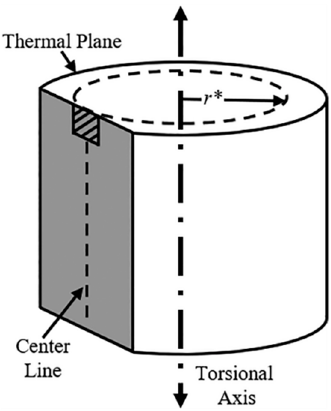
Figure 6. Schematic of the tangential orientation (evaluated at some radial position, r* ) of samples tested via hot torsion. The shaded region represents the tangential plane of interest, and the boxed region represents the approximate location of microstructural characterization.